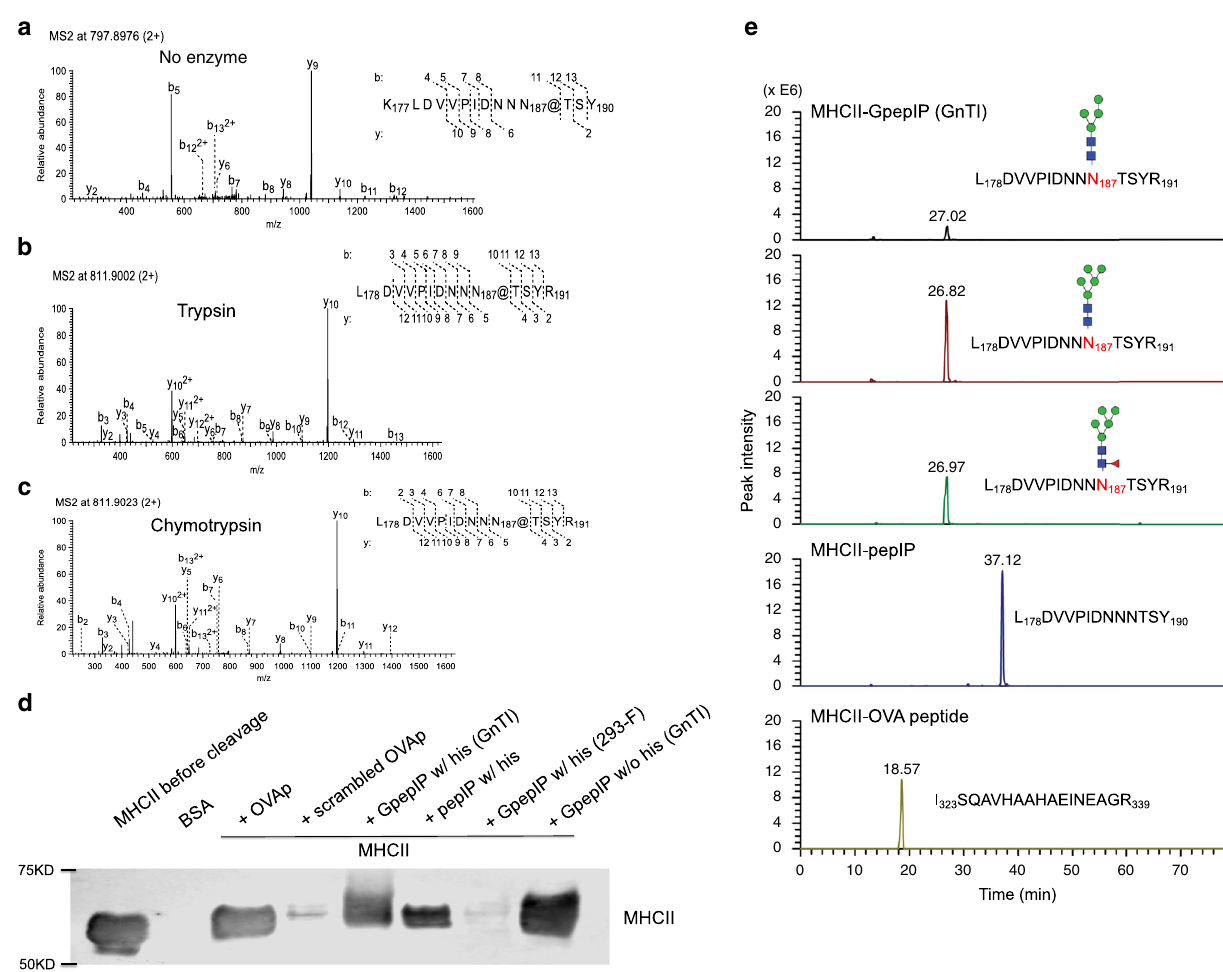
Fig. 2 Characterization of a gp120 glycotope presented by MHCII. a – c MS/MS spectra of a gp120 variable-region (V2) glycopeptide (designated GpepIP) identi fi ed from MHCII-bound epitopes shows b- and y-ions de fi ning peptide sequence KLDVVPIDNNN 187 TSY in the non-protease group a , peptide sequence LDVVPIDNNN 187 TSYR in the trypsin-treated group b , peptide sequence LDVVPIDNNN 187 TSYR in the chymotrypsin-treated group c , and the N- glycosylation site at N 187 in all three groups. The @ symbol denotes that the conversion of an Asn residue to Asp with a heavy oxygen was detected at the indicated position. d , e Binding of the GpepIP epitope to MHCII molecule was veri fi ed. d Puri fi ed MHCII monomers (mouse allele I-A d ) were loaded with an equal amount of the indicated peptides. Peptide-loaded MHCII heterodimers were detected by running of complexes in IEF gel and immunoblotting with mouse MHCII antibody. Representative results are shown from one of three independent experiments performed. e Bands corresponding to GpepIP/ MHCII, pepIP/MHCII, and OVA peptide/MHCII complexes were excised from IEF gels and subjected to LC – MS/MS analysis. Extracted ion chromatograms demonstrate the binding of three GpepIP glycoforms (M5N2 being the most abundant). PepIP and the positive control (OVA peptide) also bound and stabilized MHCII heterodimers. Source data are provided as a Source Data fi